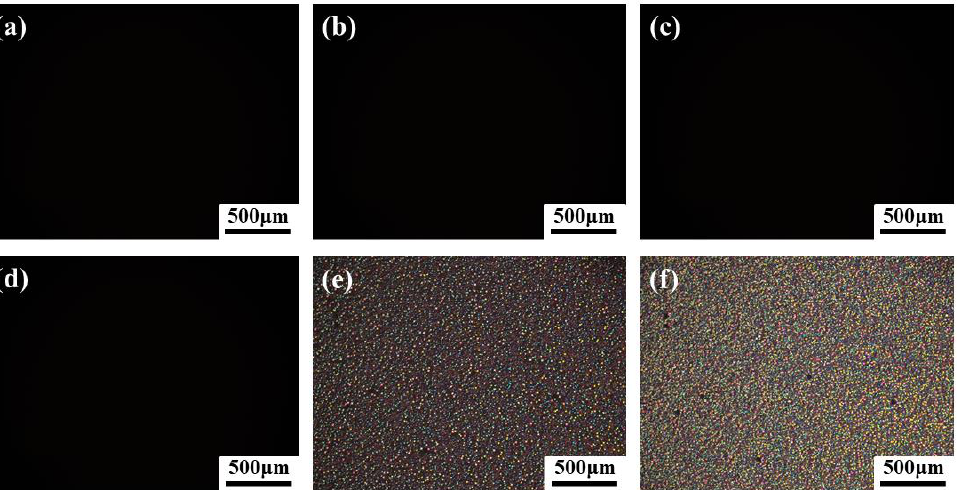
Figure 2. Temperature-dependent polarized images of LC/acrylate mixtures: ( a ) (50 °C), ( b ) (40 °C), ( c ) 30 °C), ( d ) (20 °C), ( e ) (10 °C), ( f ) (0 °C).